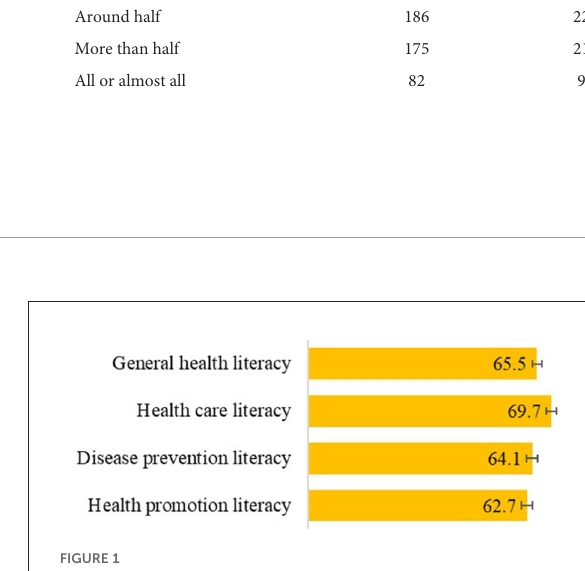
FIGURE1 Health literacy score means (means with range 0–100 and 95 % confidence